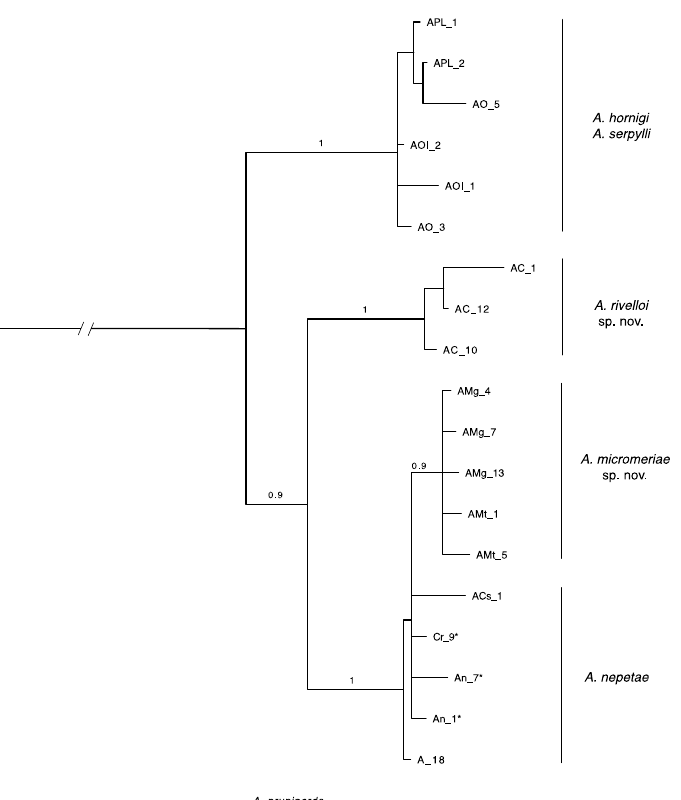
Figure 2. Bayesian majority rule consensus tree based on combined molecular markers (COI- ITS2+28S-D2) and binary data (SCG). Posterior probabilities ≥ 0.9 are shown above branches. (*) Sequences from [4].